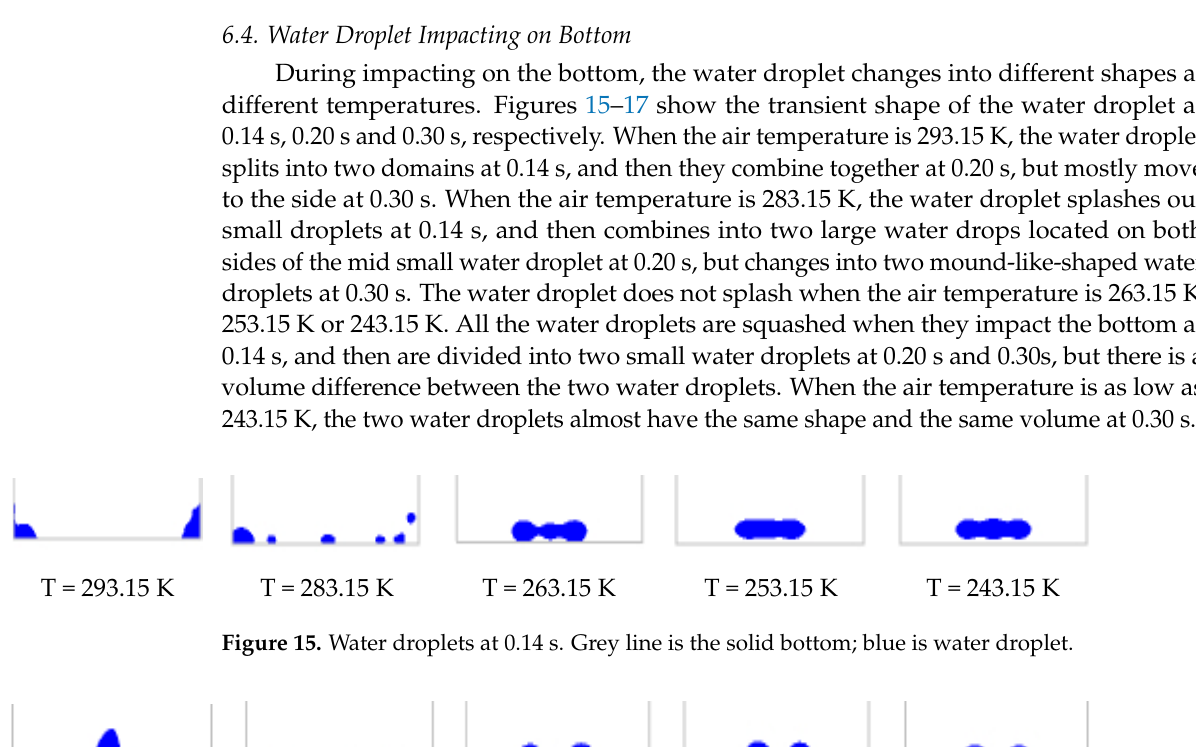
Figure 14. Viscosity of the water droplet in air at 243.15K.